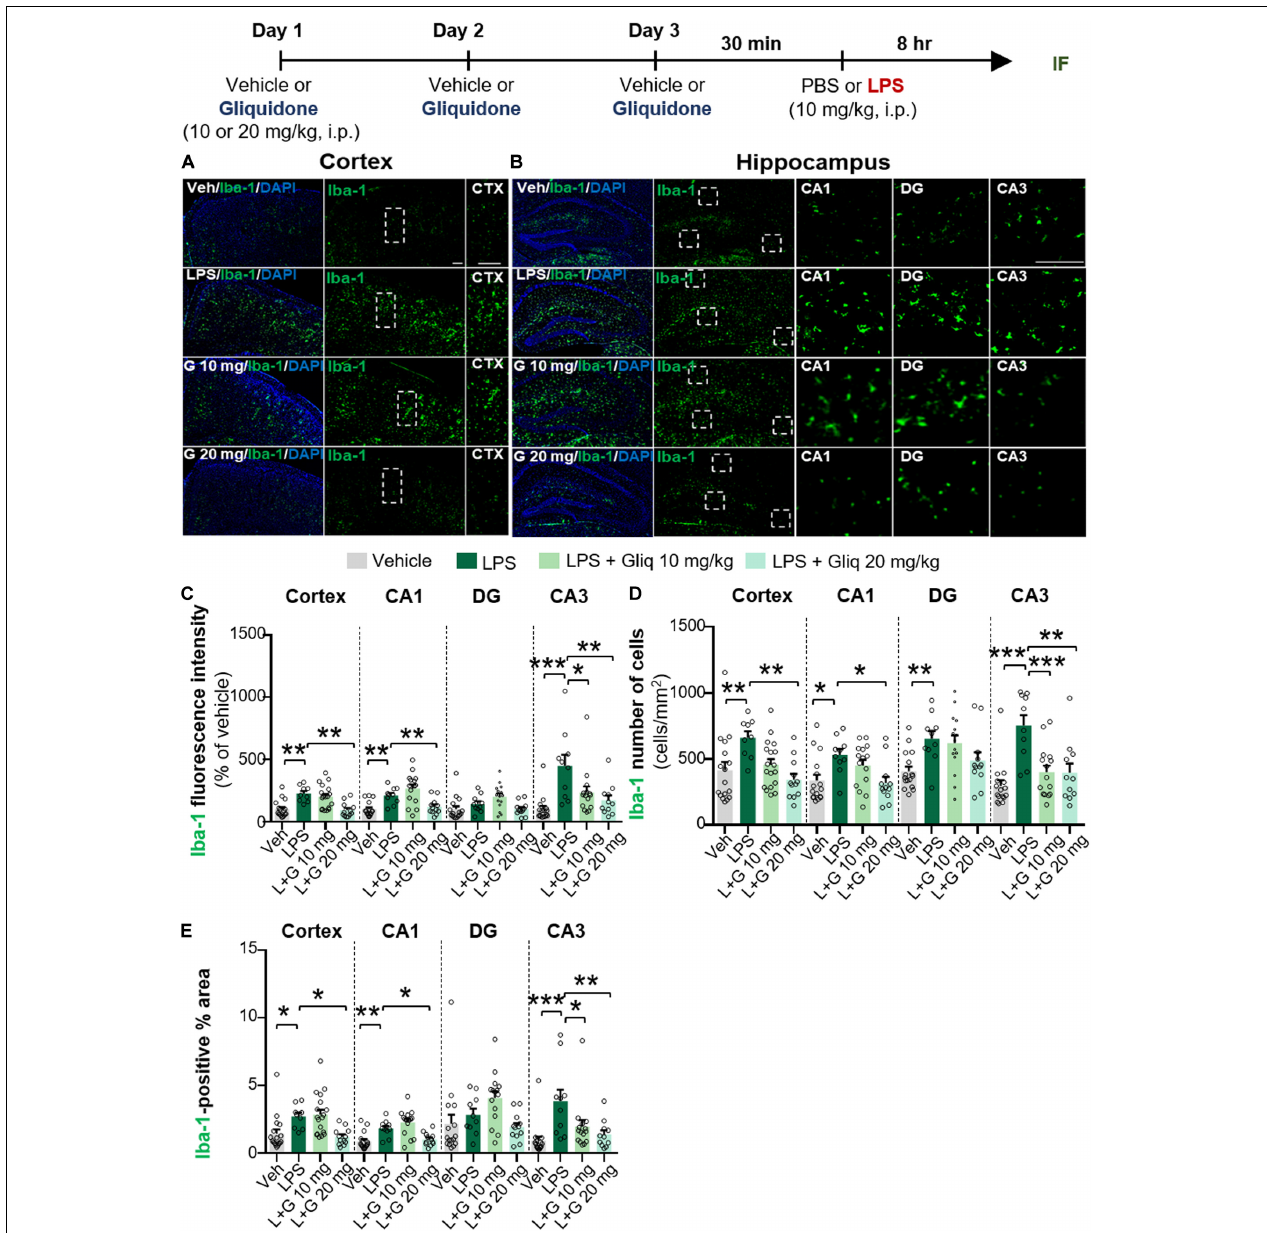
FIGURE 1 | Gliquidone decreases LPS-stimulated microgliosis and hypertrophy in the cortex and hippocampus in C57BL6/N mice. The in vivo experimental procedure for gliquidone and LPS injection is shown at the top of the figure. (A,B) Immunofluorescence staining of Iba-1 expression in brain slices from mice treated as described in the experimental procedure. (C–E) Quantification of the results in (A,B) ( n = 10–18 brain slices from 4 mice/group). * p < 0.05, ** p < 0.01, *** p < 0.001. Scale bar = 100 µ M.